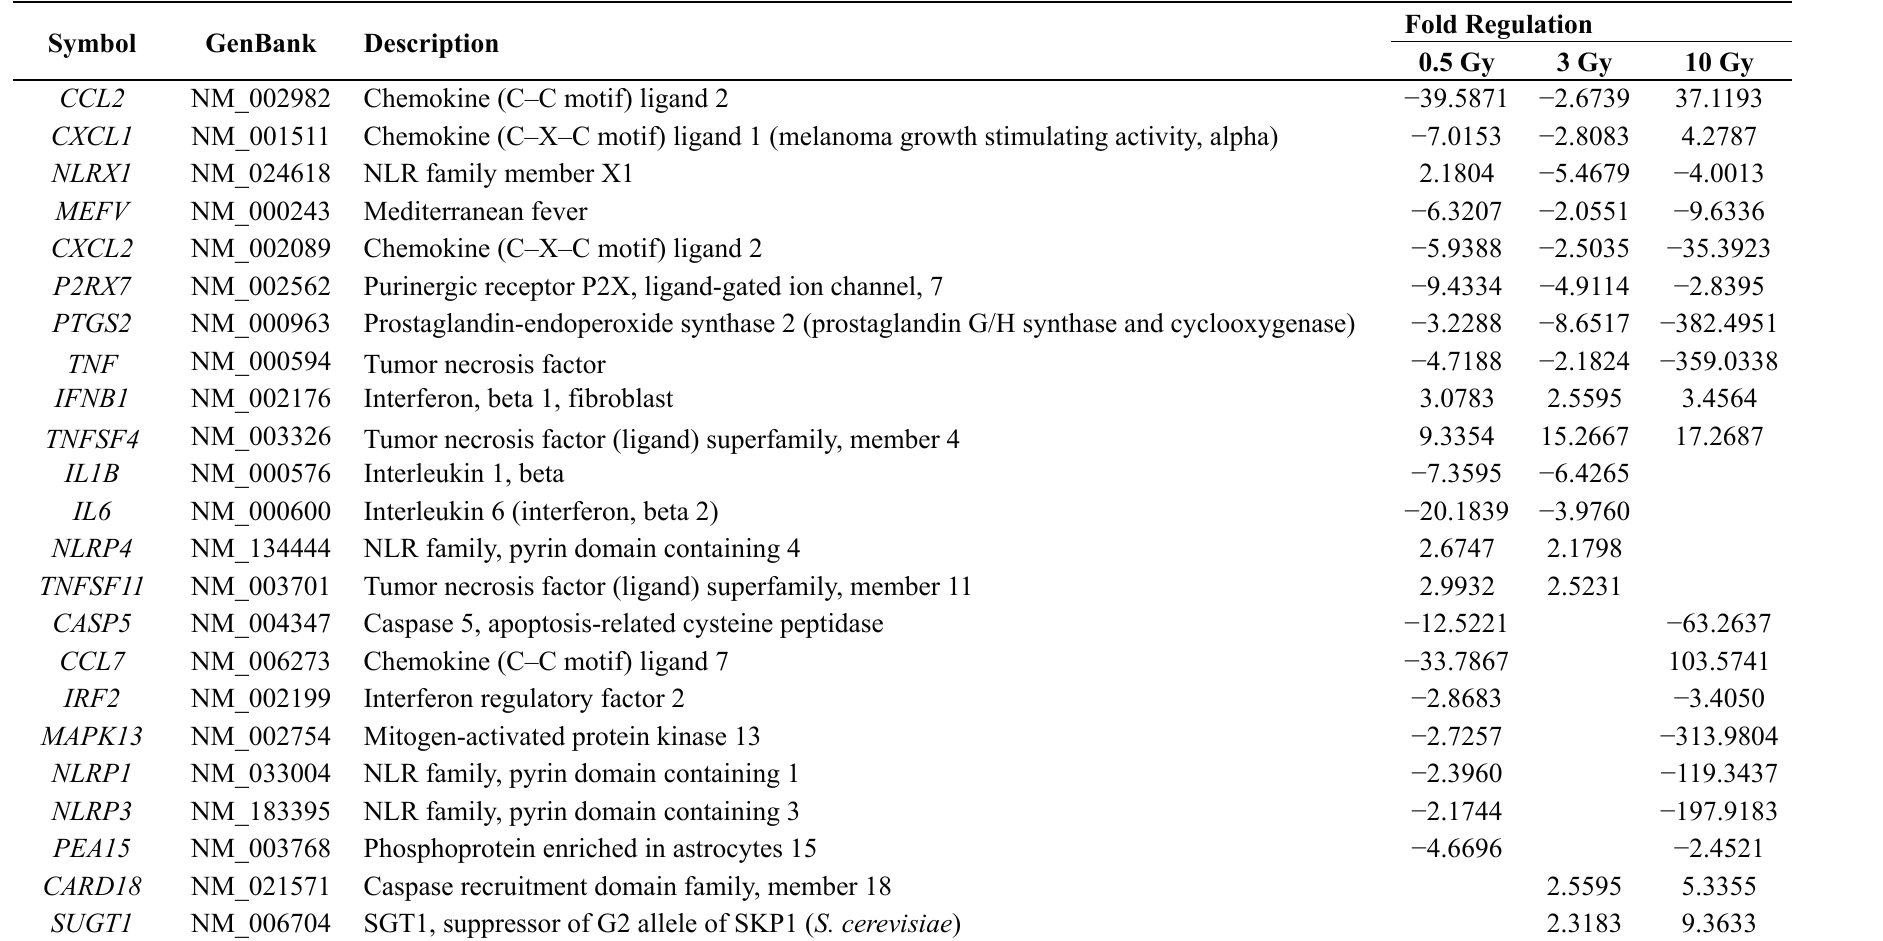
Table 2. Profiling of genes associated with X-ray-induced inflammatory